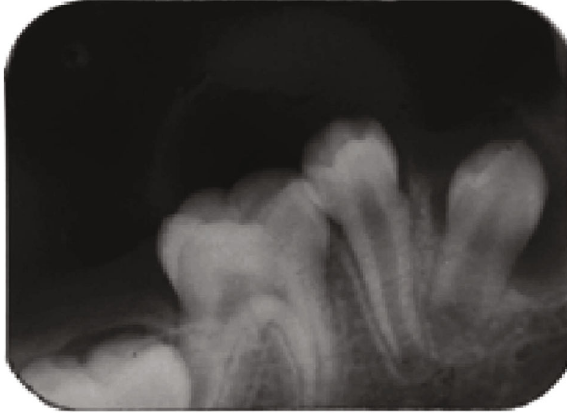
Figure 8: Three-month postoperative radiograph.